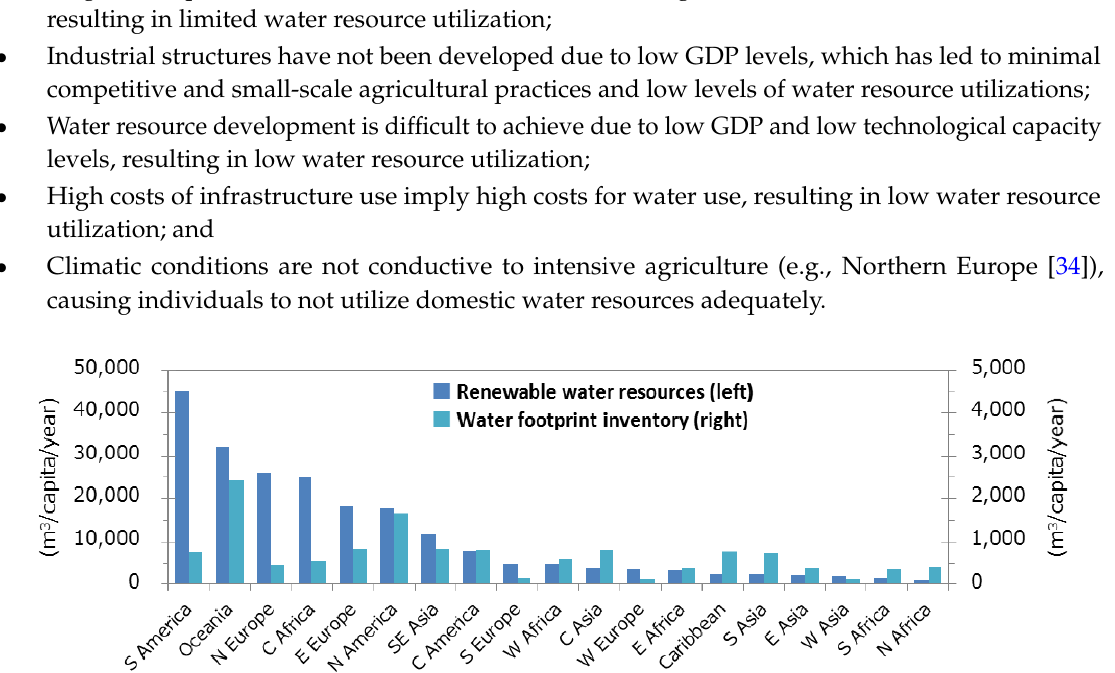
Figure 5. Renewable water resources and water footprint inventory per capita by region.